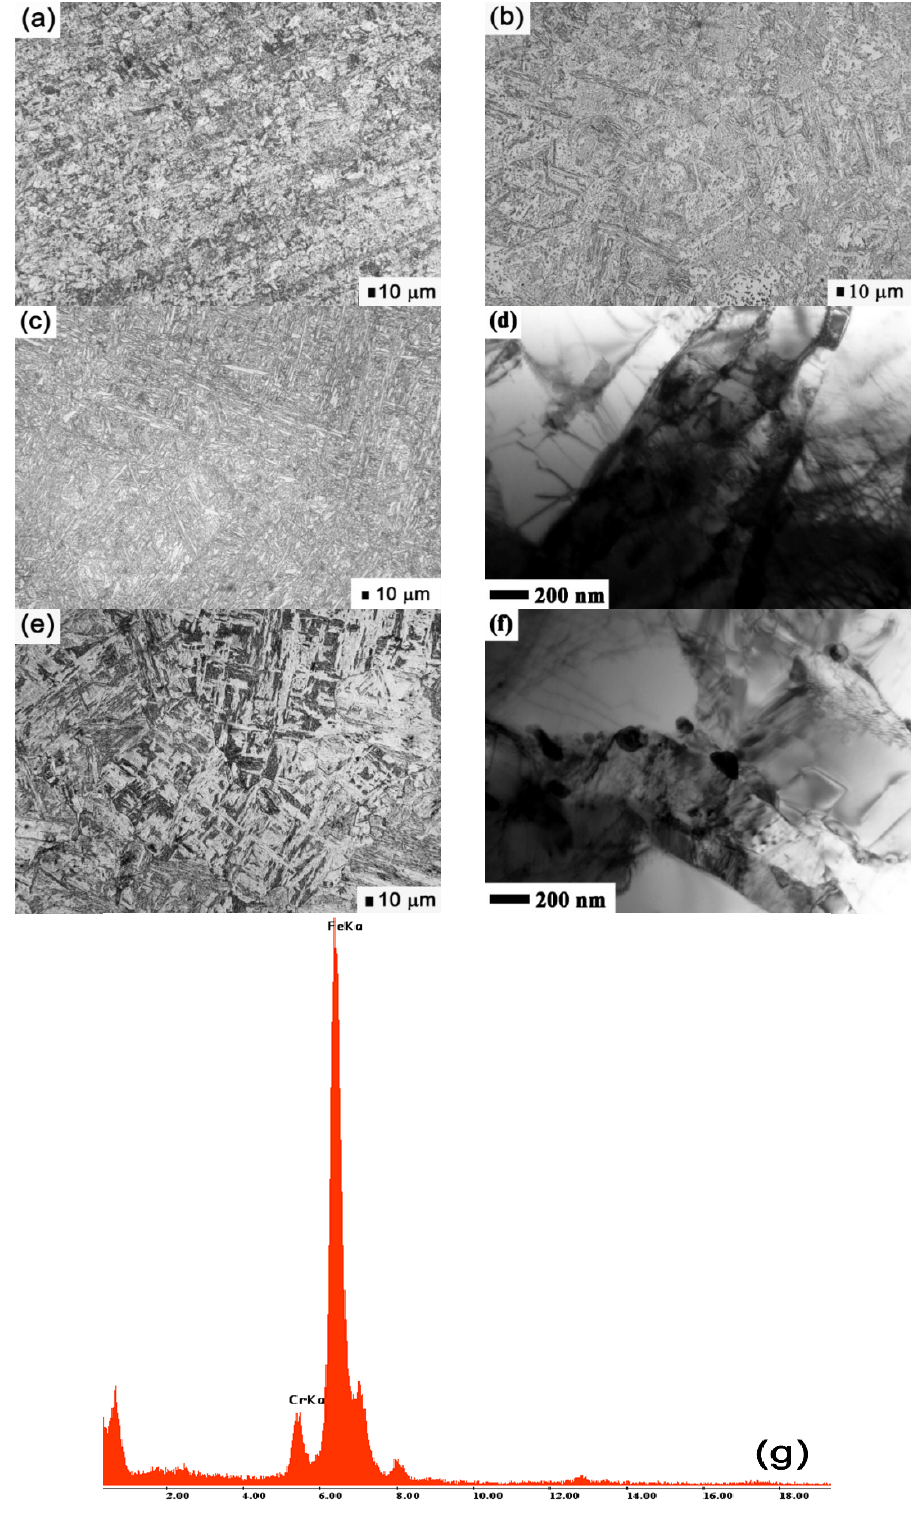
Figure 2. As-normalized optical micrograph ( a ) normalized at 1020 °C for 2 h; ( b ) normalized at 1100 °C for 2 h; ( c ) normalized at 1040 °C for 2 h; ( d ) TEM micrograph of sample normalized at 1040 °C for 2 h; ( e ) optical micrograph of sample normalized at 1040 °C for 8 h; ( f ) TEM micrograph of a sample normalized at 1040 °C for 8 h; and ( g ) the EDS spectrum of M 23 C 6 type precipitate shown in Figure